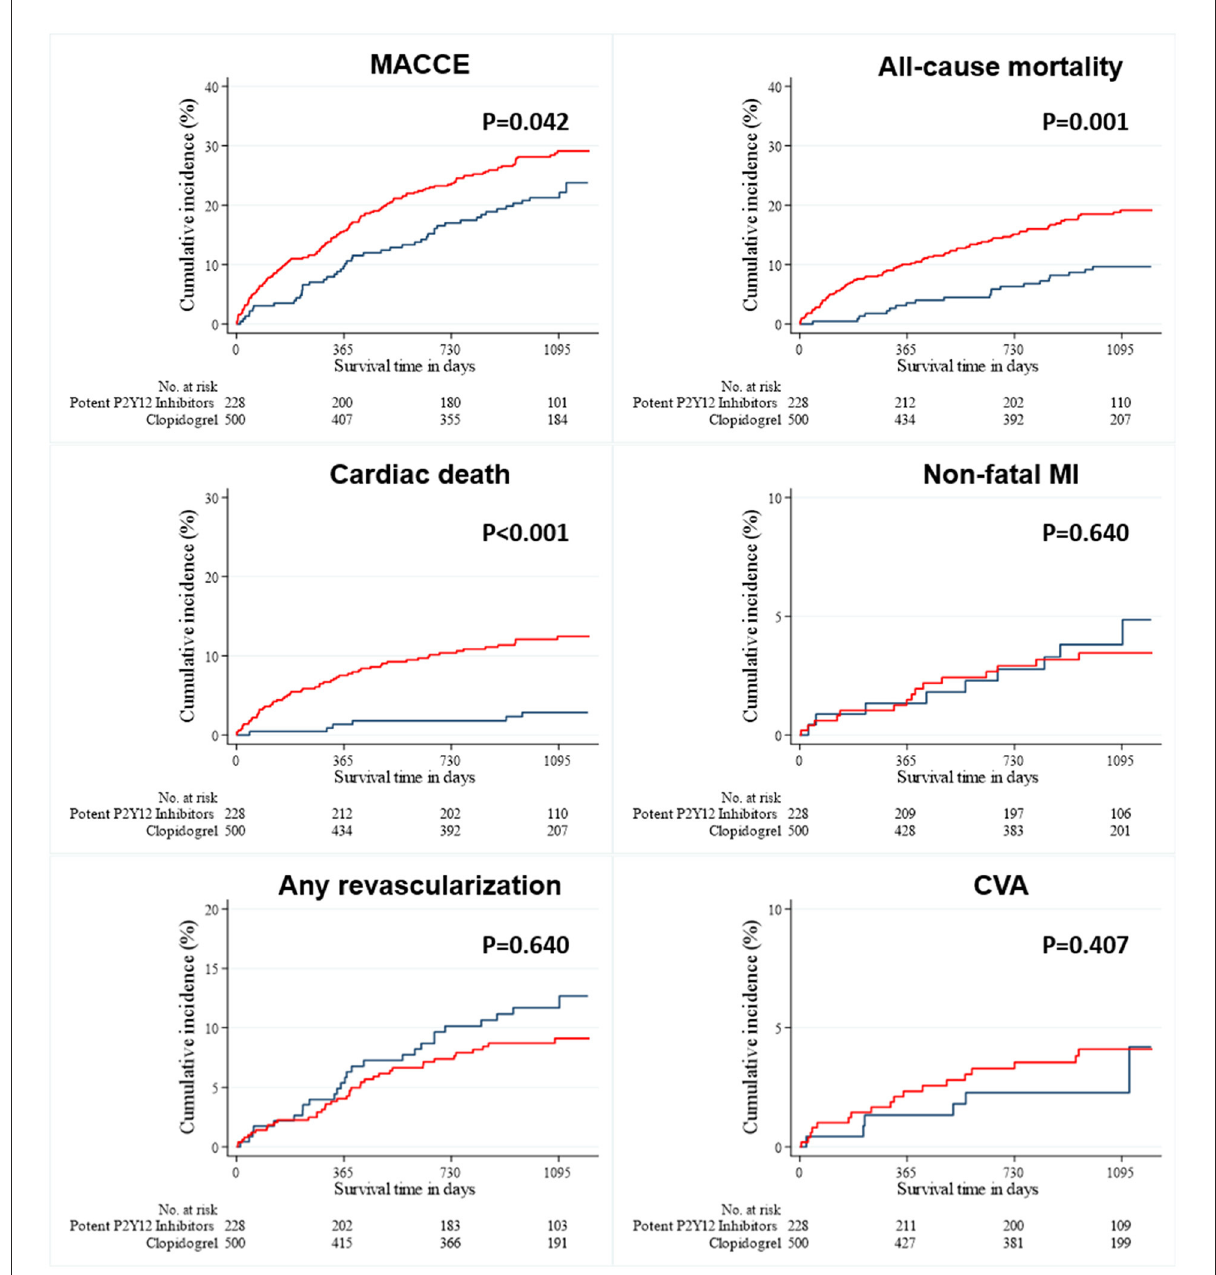
FIGURE2 Event rates of clinical outcomes for all the patients after a 3-year follow-up (before PSM-and IPTW-adjusted analysis). The Kaplan–Meier curves for cumulative event rates according to the type of P2Y12 receptor inhibitors are shown. The red curve indicates group A, and the blue curve indicates group B. CVA, cerebrovascular accident; IPTW, inverse probability of treatment weighting; MACCE, major adverse cardiac and cerebrovascular event; MI, myocardial infarction.